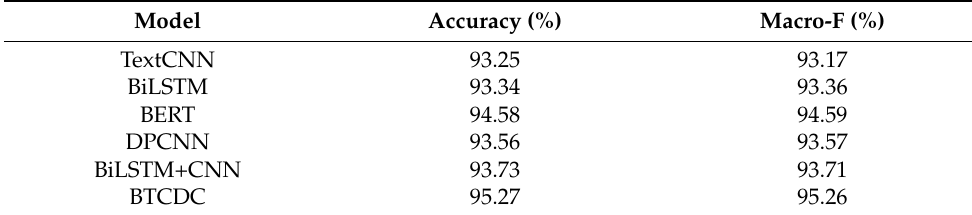
Table 2. Experimental results on the THUCNews